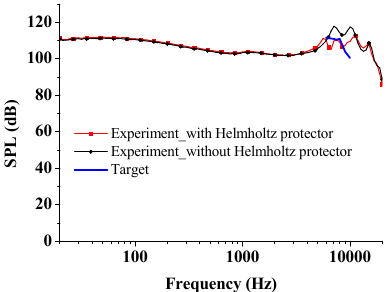
Figure 25. Experimental results (with/without Helmholtz protector).